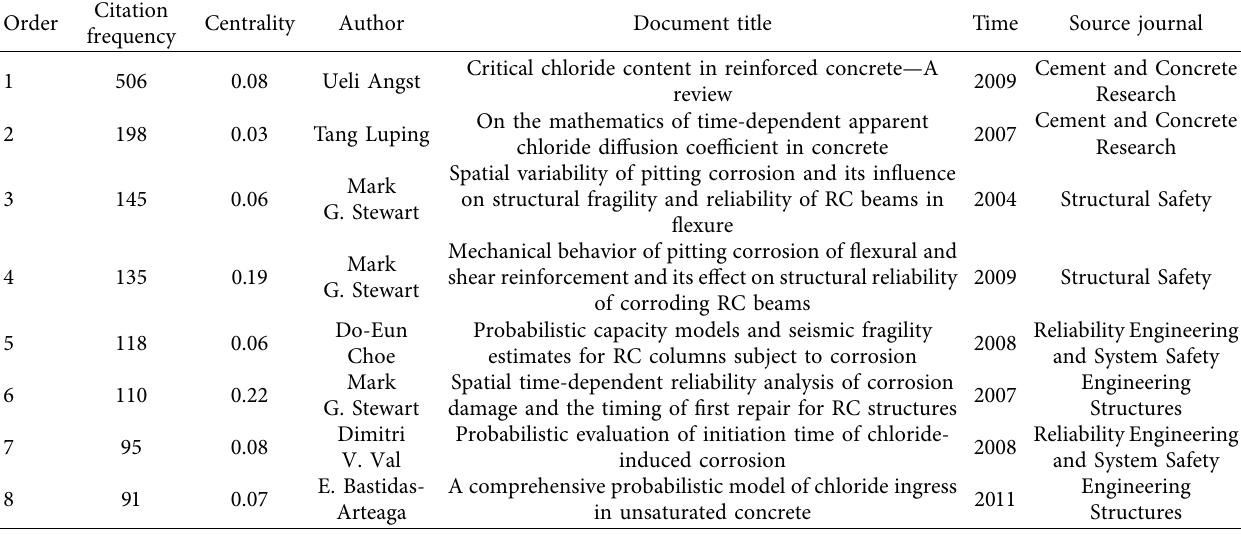
Table 5: Top 8 documents with higher citations on time to corrosion initiation evaluation research.